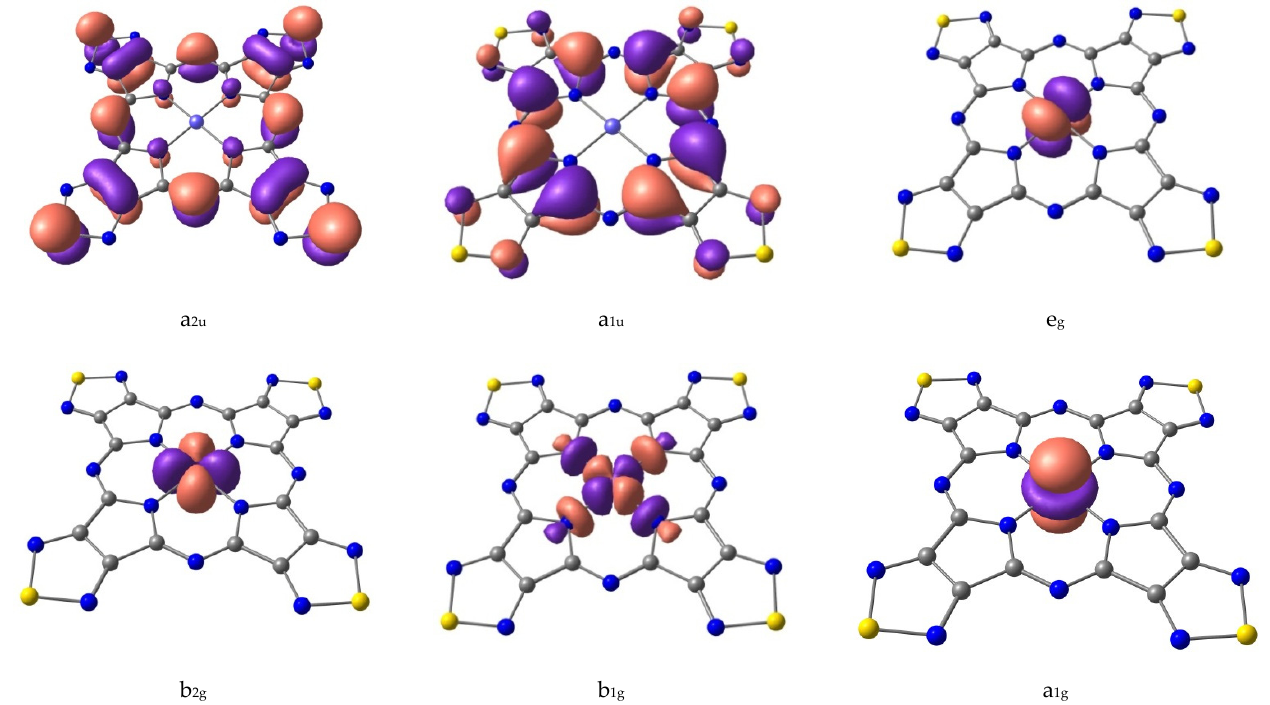
Figure 3. Shapes of active CASSCF molecular orbitals of NiTTDPz.